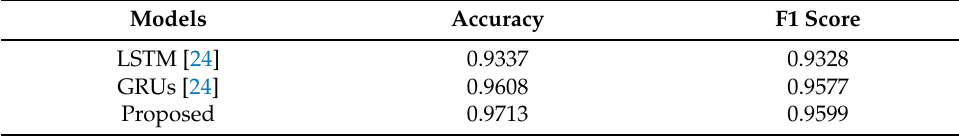
Table 19. Comparison with other deep learning